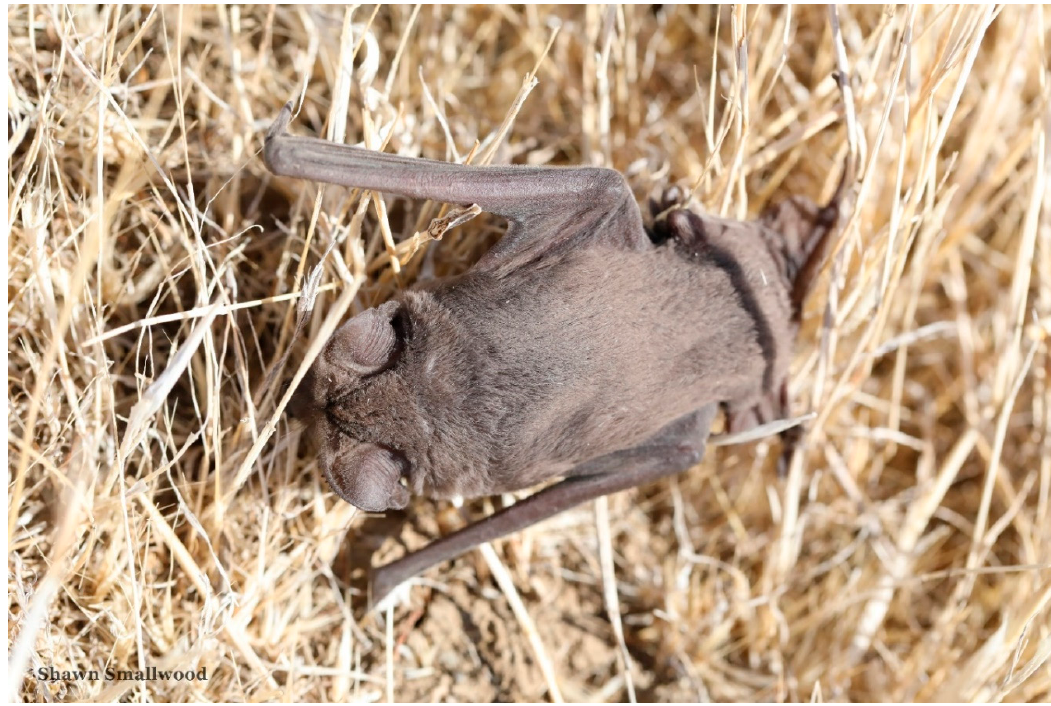
Figure 8. This Mexican free-tailed bat ( Tadarida brasiliensis ) was found by Smallwood as depicted, face-down under a Golden Hills wind turbine. Assuming the bat was dead, but checking to make certain, Smallwood nudged the bat with a boot. The bat flew up to hover near Smallwood’s face for a few seconds, and then flew 50 m away before dropping to the ground.